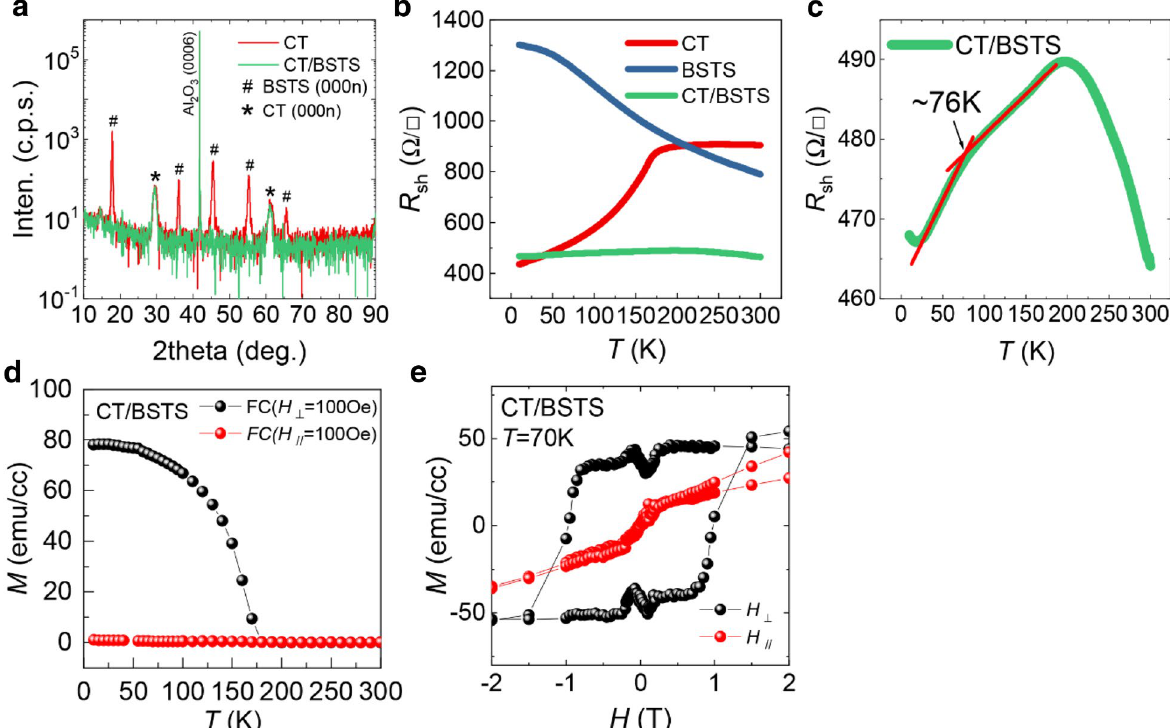
Fig. 1 Basic physical properties of CT and BSTS. a XRD theta‑2theta scans of CT (red) and CT/BSTS (green). b Sheet resistance as a function of temperature R sh ( T ) of CT (red), BSTS (blue), and CT/BSTS heterostructure (green). c An expansion of R sh ( T ) of CT/BSTS to highlight the bump at ~ 76 K. d , e The magnetization of CT/BSTS heterostructure as a function of temperature ( d ) and external magnetic field ( e ) at T in‑plane (red) and the out‑of‑plane (black) magnetic field directions. All the measurements here use the 8 nm CT and 100 nm BSTS